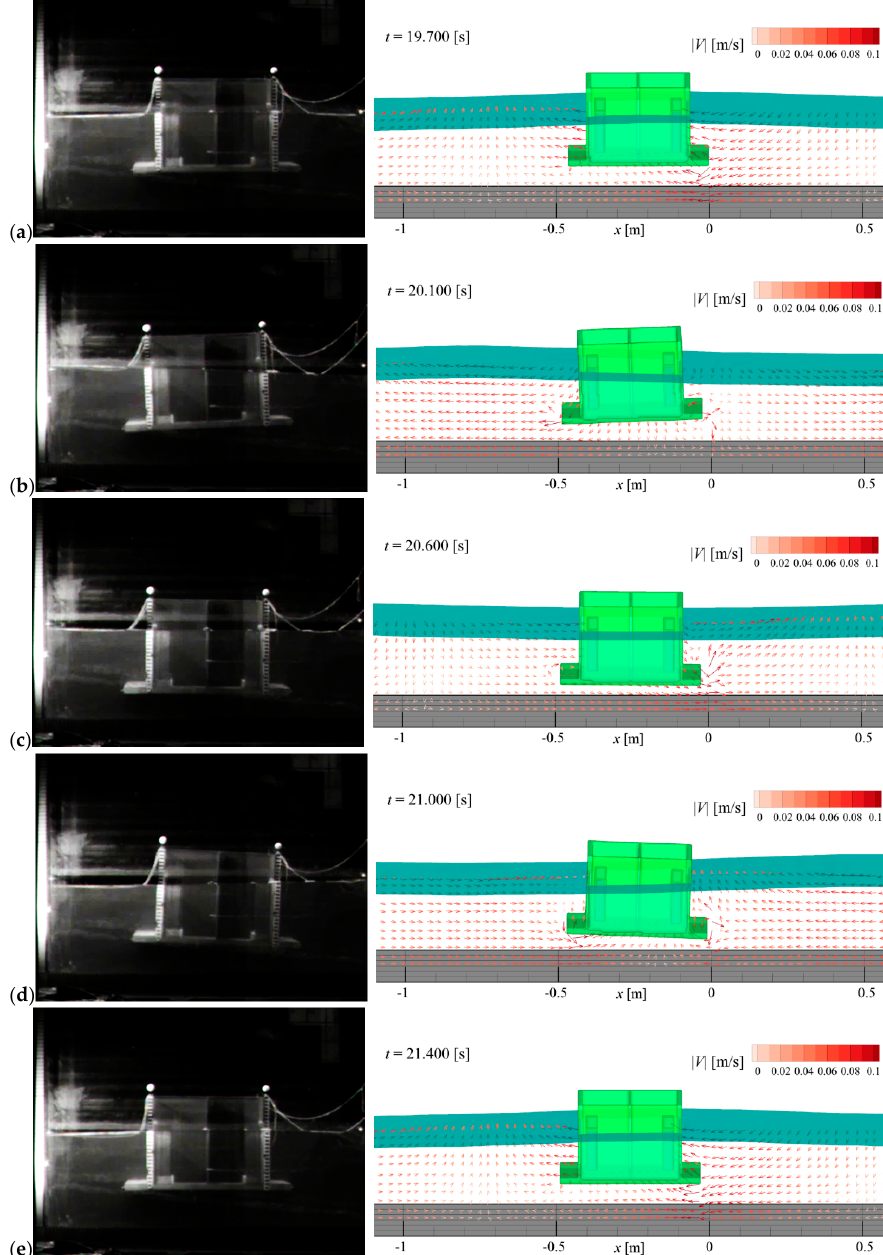
Figure 15. Comparison of the wave deformation for T i = 1.70 s ( f i = 0.59 Hz) and b f = 60 mm (left: experimental data; right: numerical results): ( a ) t = 19.7 s, ( b ) t = 20.1 s, ( c ) t = 20.6 s, ( d ) t = 21.0 s, and ( e ) t = 21.4 s.